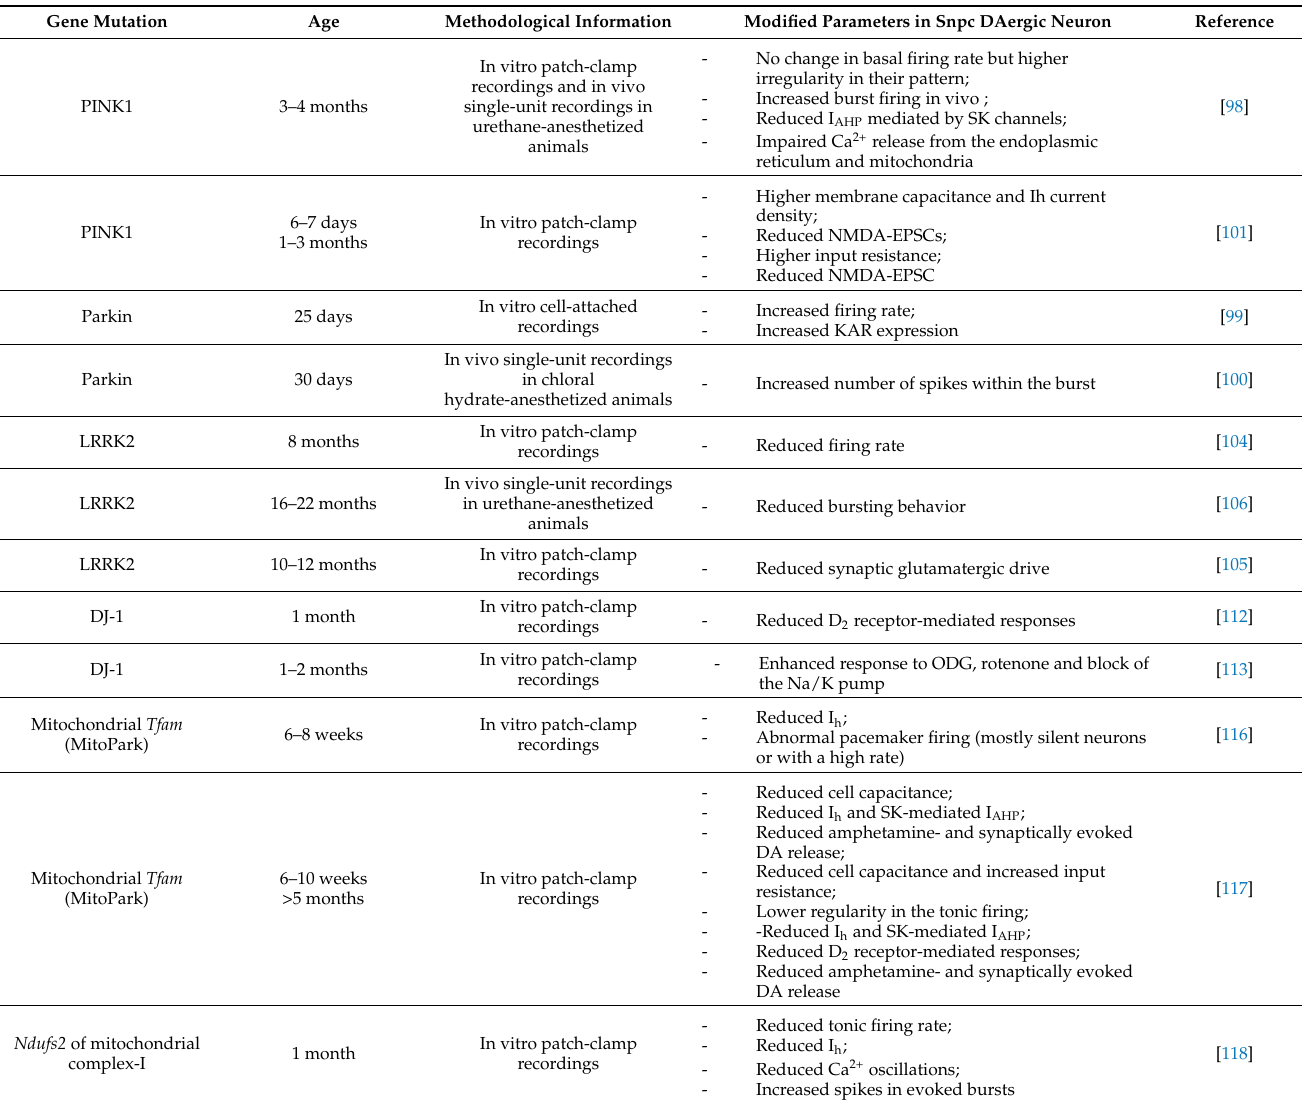
Table 5. Summary of the principal findings reported by the cited literature on genetic manipulation effects on SNpc DAergic neuron functional